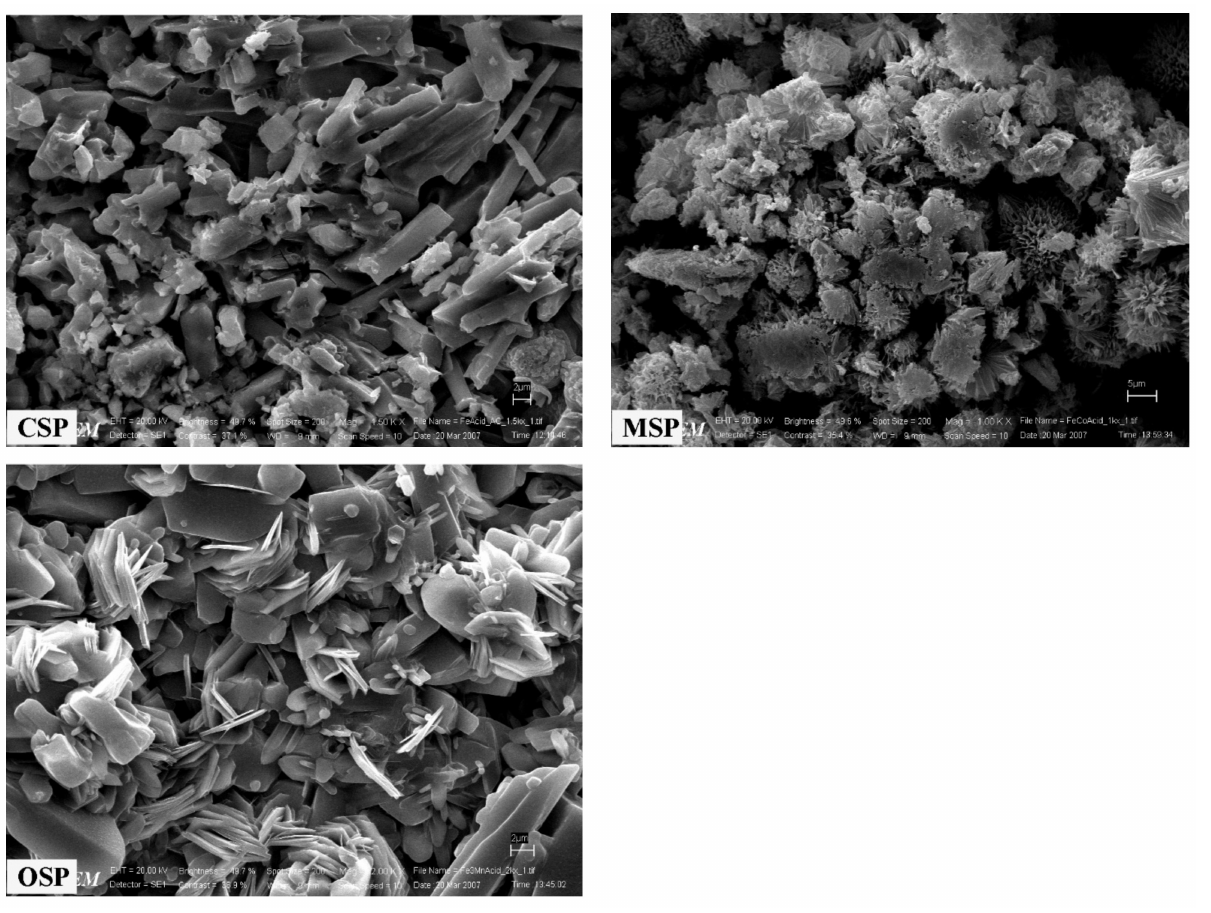
Figure 5. SEM micrographs of the bivalve shell (CSP, MSP and OSP)